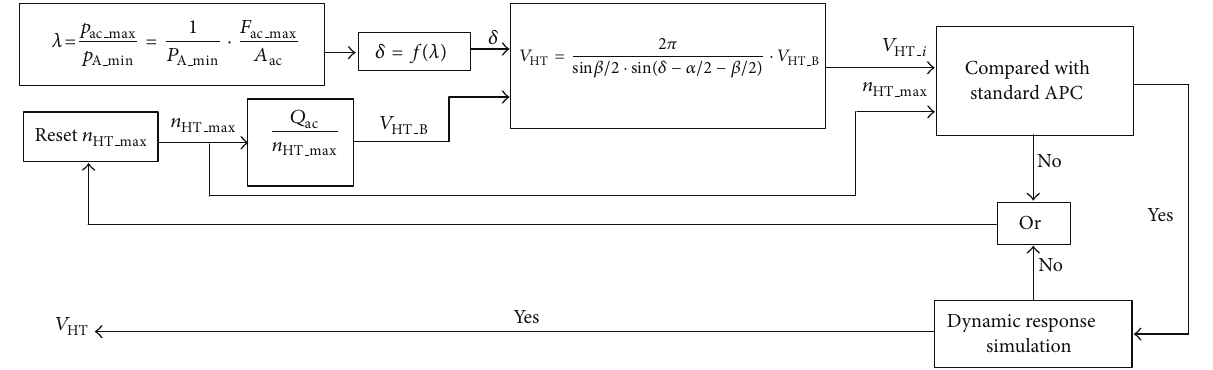
Figure 3: Flow chart of sizing SHT.